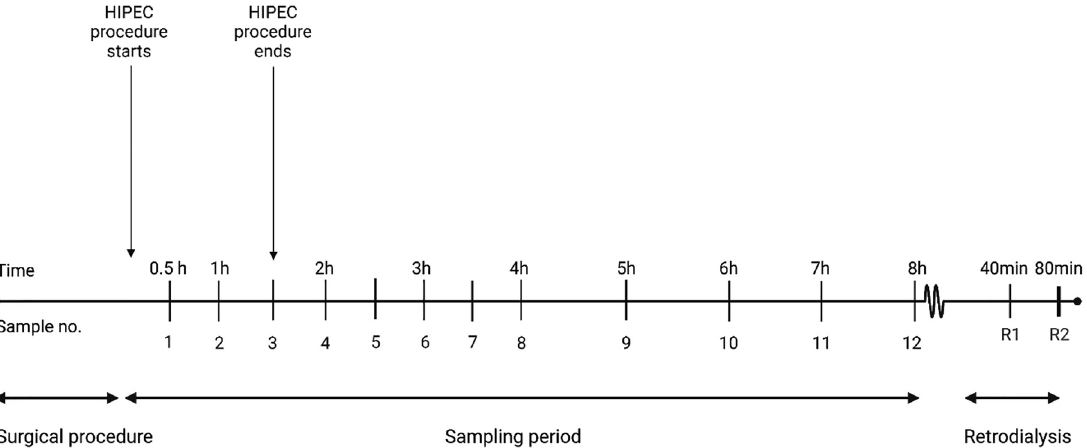
Figure 1: Timeline illustrating the sampling process. Timeisshownabovethetimelineandsamplenumbersareshownunderthetimeline.Recoverysamplesfromthecalibrationperiodarenamed R1 and R2 (Created with